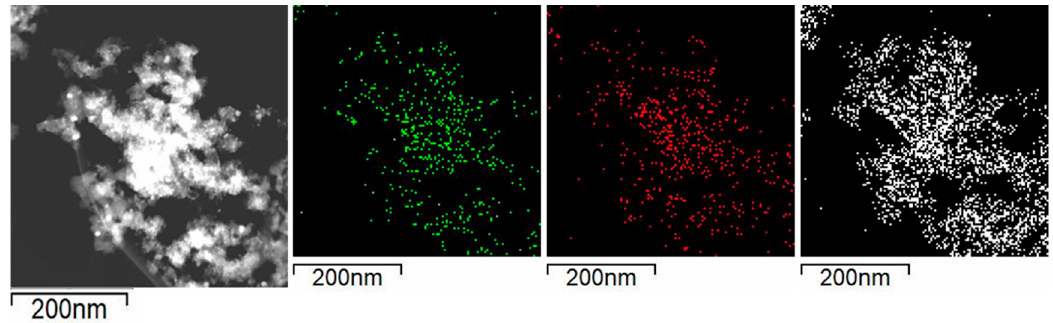
Figure 5. Transmission electron microscopy (TEM) images of reduced samples: ( a ) Ni/SiO 2 and (b ) Ni/Ca(19.3)-SiO 2 ; the histograms were included.